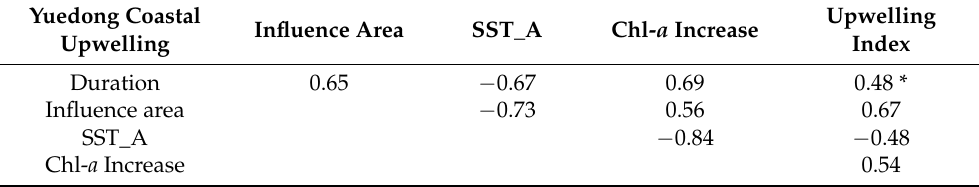
Table 3. Correlation coefficients between characteristics of Qiongdong coastal upwelling (n = 20, p = 0.01). Qiongdong Coastal Influence Area SST_A Chl- a Increase Upwelling Duration